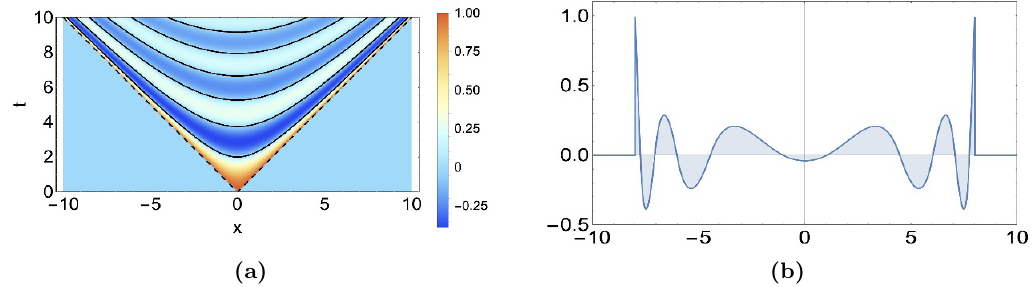
Figure 20 . The exact shock wave solution for a 0 = 1. (a) The solution on the space-time diagram and (b) the snapshot of the solution for t = 8 : 0.